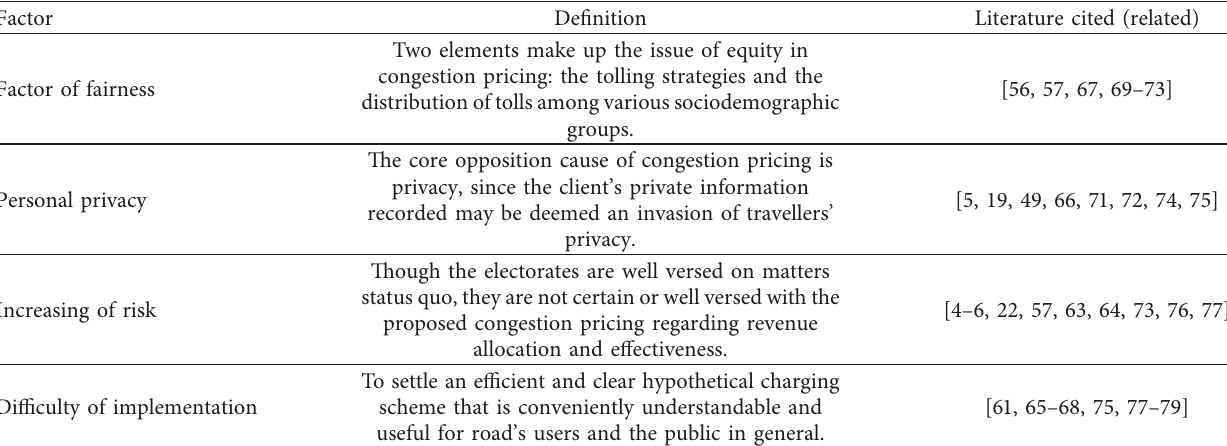
Table 2: Explanations and key references of the four main influencing factors of congestion pricing. Factor Definition Factor of